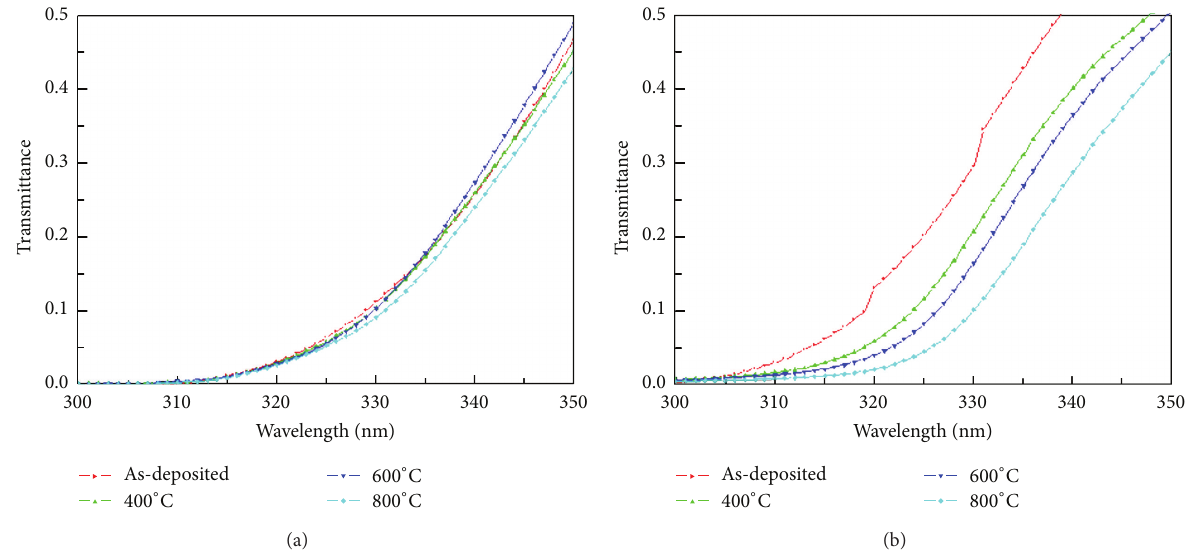
Figure 5: Partial enlarged drawing of transmittance spectra from (a) Ti 3 O 5 and (b) TiO 2 starting materials in the wavelength region between 300 and 350 nm.